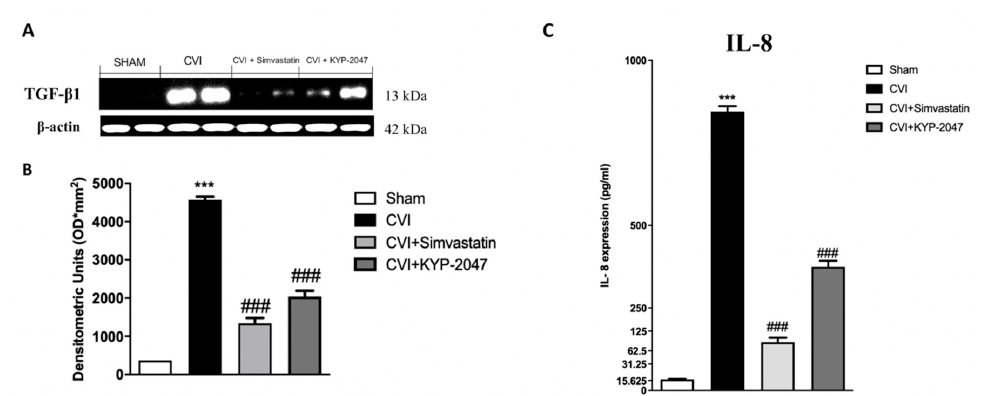
Figure 2. KYP-2047 treatment on TGF- β 1 expression and IL-8 content. TGF- β 1 expression was analyzed by Western Blot, suggesting an increment of this marker in CVI group, compared to control animals ( A ), see the densitometric units score ( B ); treatment with KYP-2047 significantly reduced TGF- β 1 expression ( A ), see the densitometric units score ( B ). ELISA kit for IL-8 expression on saphene vein samples was performed; treatment with KYP-2047 (10 mg/kg, i.p.) significantly reduced IL-8 quantification ( C ), compared to the high amount of IL-8 released in the vein samples subjected to damage ( C ). Data represent the means of at least three independent experiments. One way ANOVA followed by Bonferroni post-hoc. *** p < 0.001 versus Sham; ### p < 0.001 versus CVI.